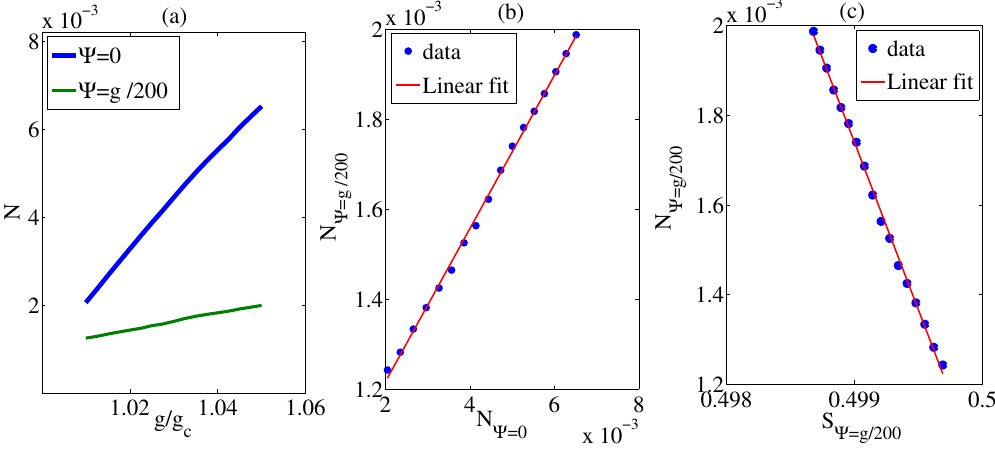
Figure 4. Entanglement (logarithmic negativity) between the two atomic ˆ b and ˆ c modes as a function of g/g ( a ) in the presence ( Ψ (cid:54) = 0 ) and absence ( Ψ = 0 ) of the auxiliary ˆ w mode. c vs. N The linear dependences in the two cases lead to proportionality ( b ); N . Dots are Ψ (cid:54) =0 Ψ=0 numerical data, while the solid line a least squares linear fit. ( c ) The logarithmic negativity is displayed vs . the single mode squeezing S of the auxiliary mode. As is clear, increasing Ψ (cid:54) =0 the atom-atom entanglement implies an increased squeezing of the ˆ w mode, which suggests that squeezing would be an indirect measure of entanglement in the system. Other parameters = 1 , κ = 0 . 05 and γ = 0 . 05 κ include δ = − 1 , ω R